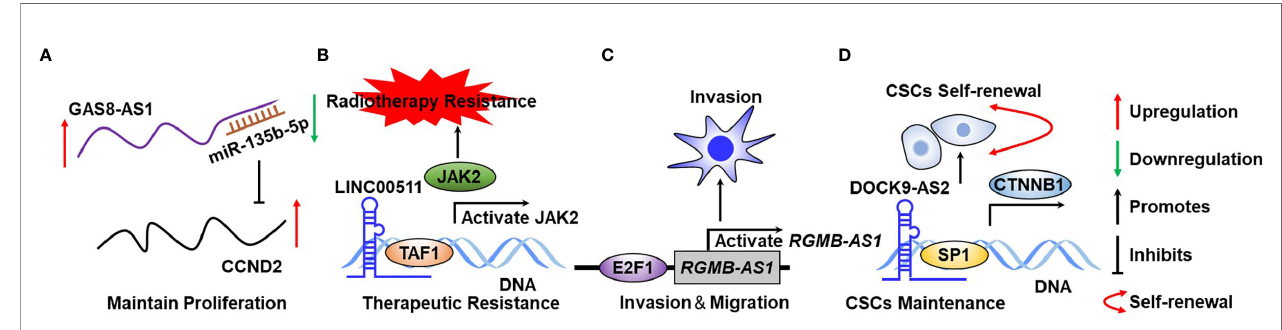
FIGURE 4 | The biological function of lncRNA in TC hallmarks. (A) GAS8-AS1 sustains TC cell growth through binding to miR-135b-5p in a complementary base pairing manner. (B) LncRNA00511 activates JAK2 expression at the transcriptional level through binding to DNA. (C) E2F1 activates RGMB-AS1 expression at the transcriptional level to maintain TC cell migration. (D) DOCK9-AS2 binds to SP1 by serving as a scaffold protein to sustain CSC